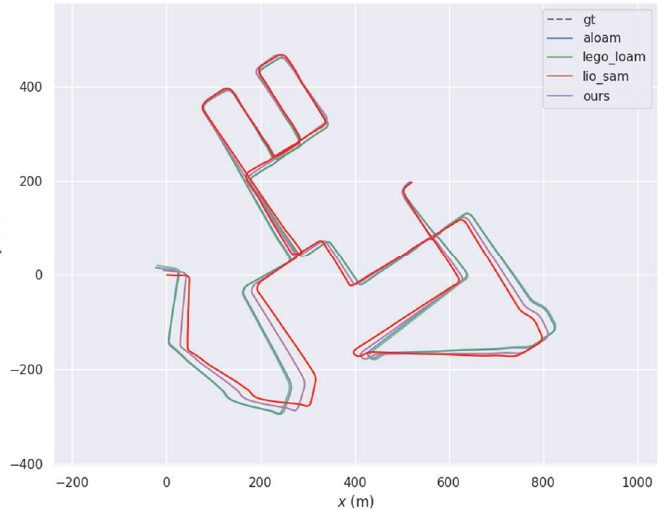
Figure 3. Comparison between the motion trajectories generated by the four different algorithms and the true values.